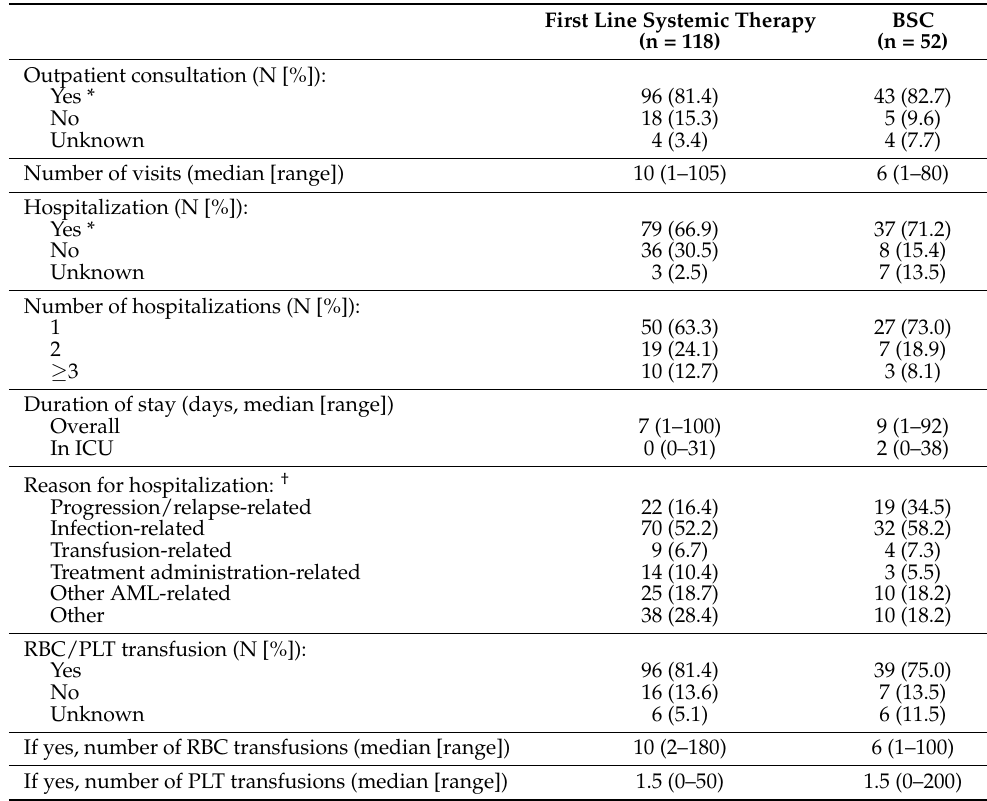
Table 5. Healthcare resource utilization during first line